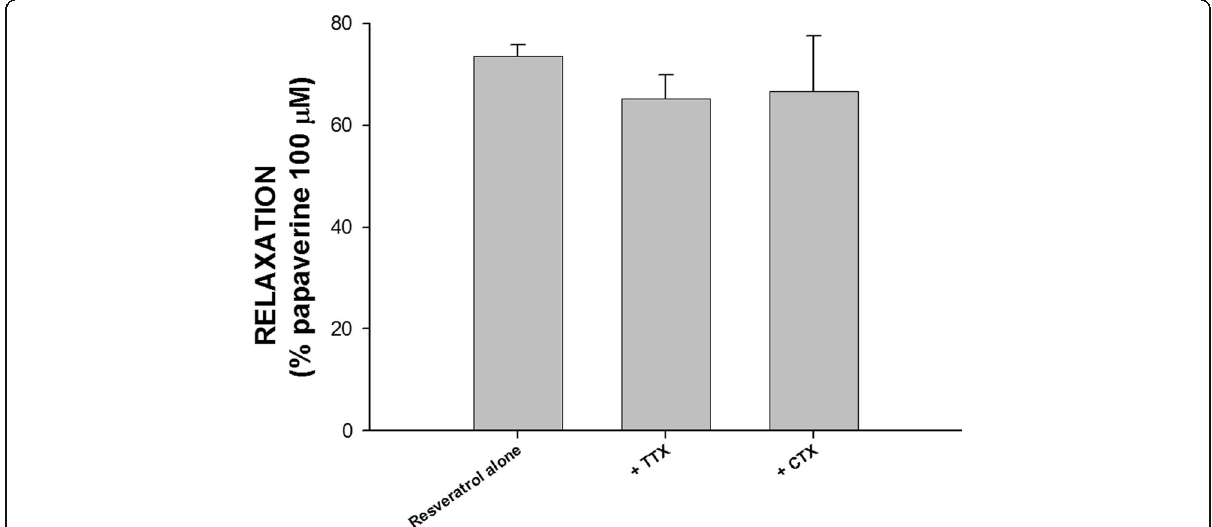
Fig. 3 The effects of tetrodotoxin (TTX) and ω -conotoxin GVIA (CTX) on resveratrol-induced relaxation in the human gallbladder. TTX (1 μ M) and CTX (1 μ M) had no significant effect on resveratrol-induced relaxation of human gallbladder muscle strips. The results shown are from at least three experiments. The vertical bars represent ± standard error of the mean